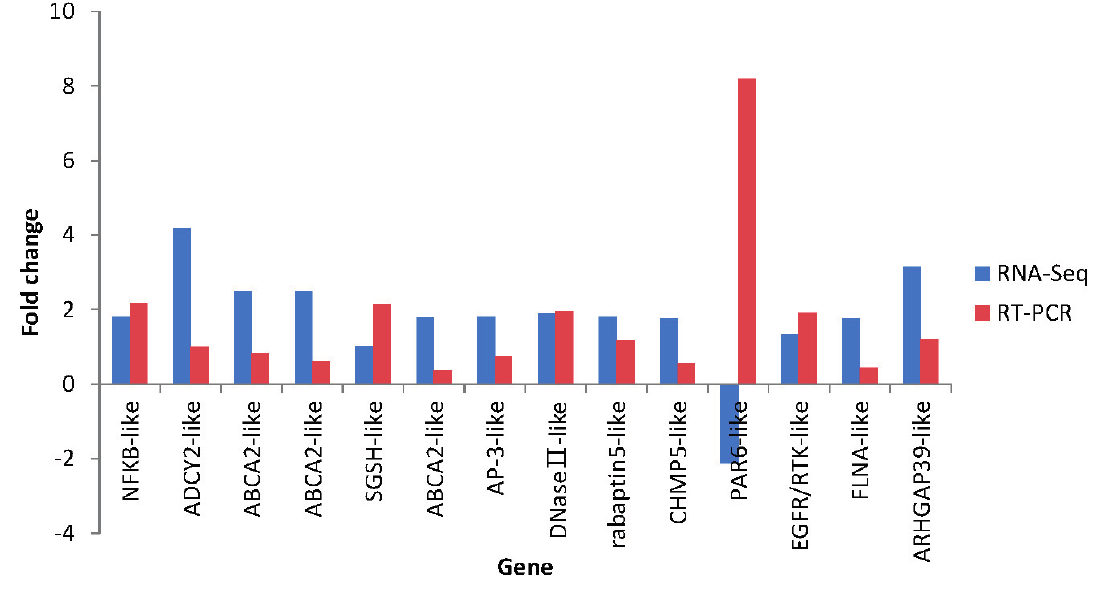
Figure 16. Comparison of 14 putative susceptibility gene expression levels between RNA-Seq (blue bar) and RT-PCR (red bar). “ − ”indicates